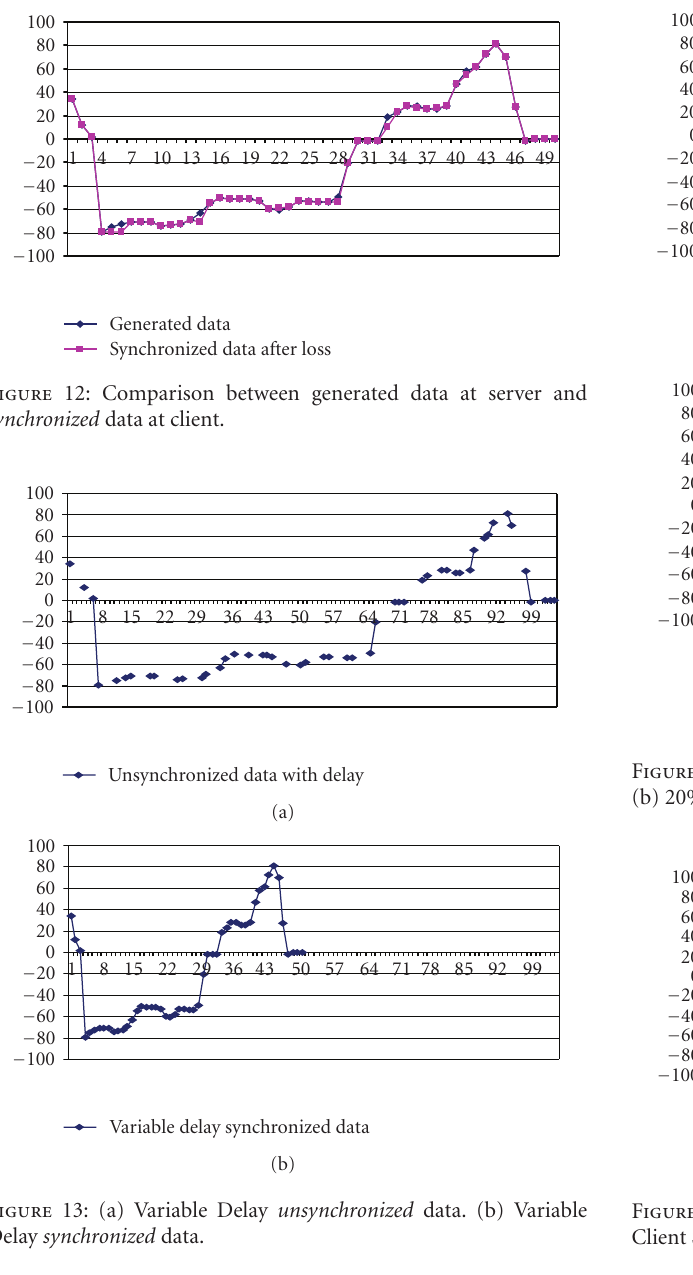
Figure 15: X -axis Positional Deviation Comparison at Server and Client